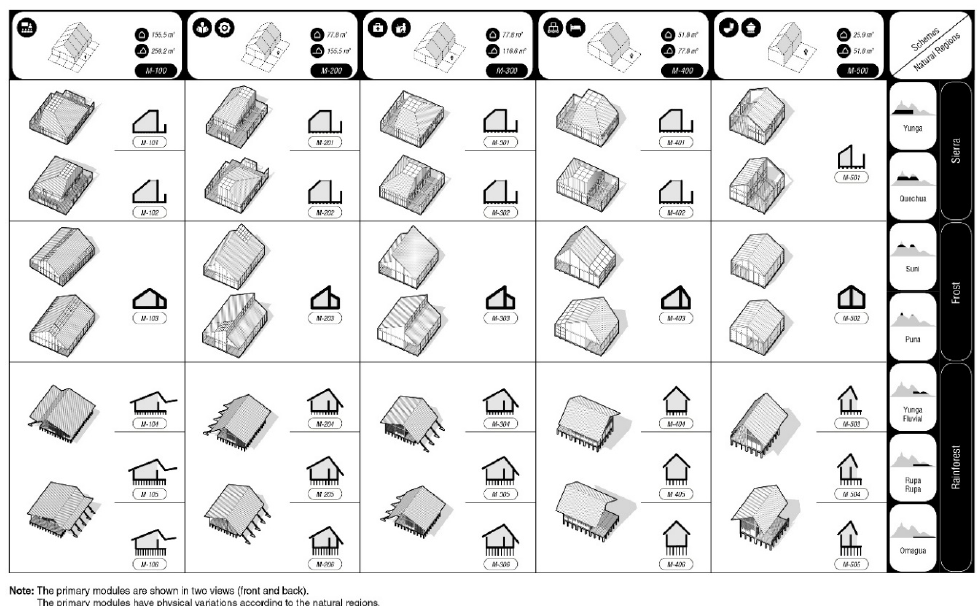
Figure 13. The systematic catalog: primary modules